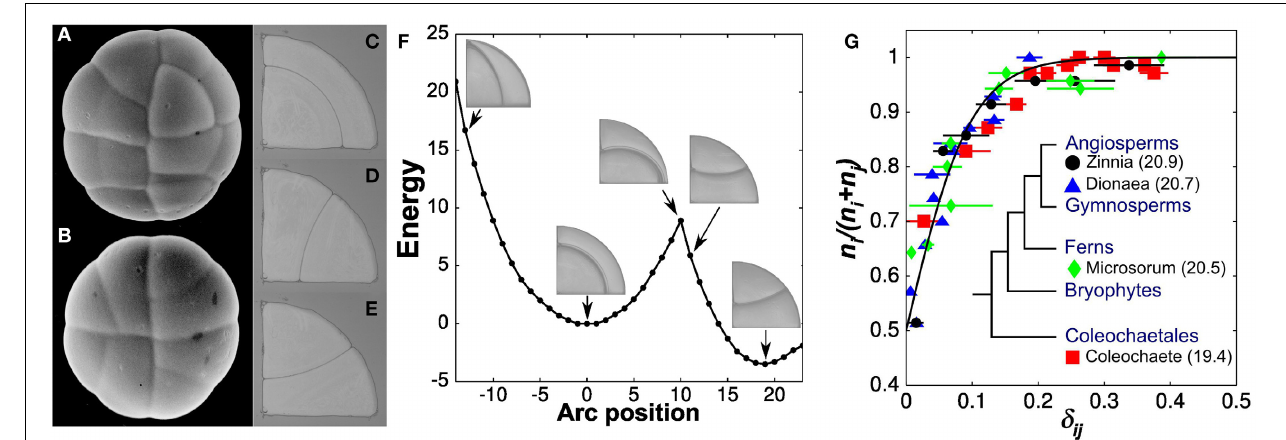
FIGURE 1 | Stochastic rule for the selection of a division plane. (A,B) Two glandular trichomes showing the quadrant cells studied by Berthold and Thompson. Each circular gland divides twice across its center to produce four quadrant cells. These quadrant cells can undergo three types of division, all of which are predicted by soap films (C–E) . The division plane with least area is anticlinal, forming a wedge cell and a triangular cell (D,E) . The other division is